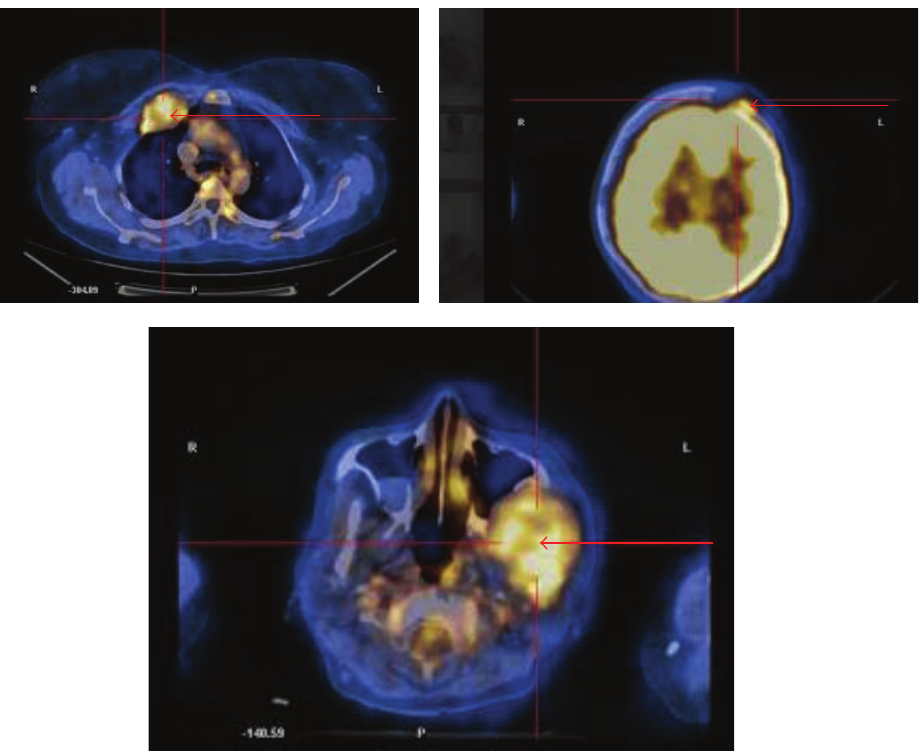
Figure 6: PET CT images showing extensive FDG uptake in frontal bone, maxilla, and right costochondral junction of second